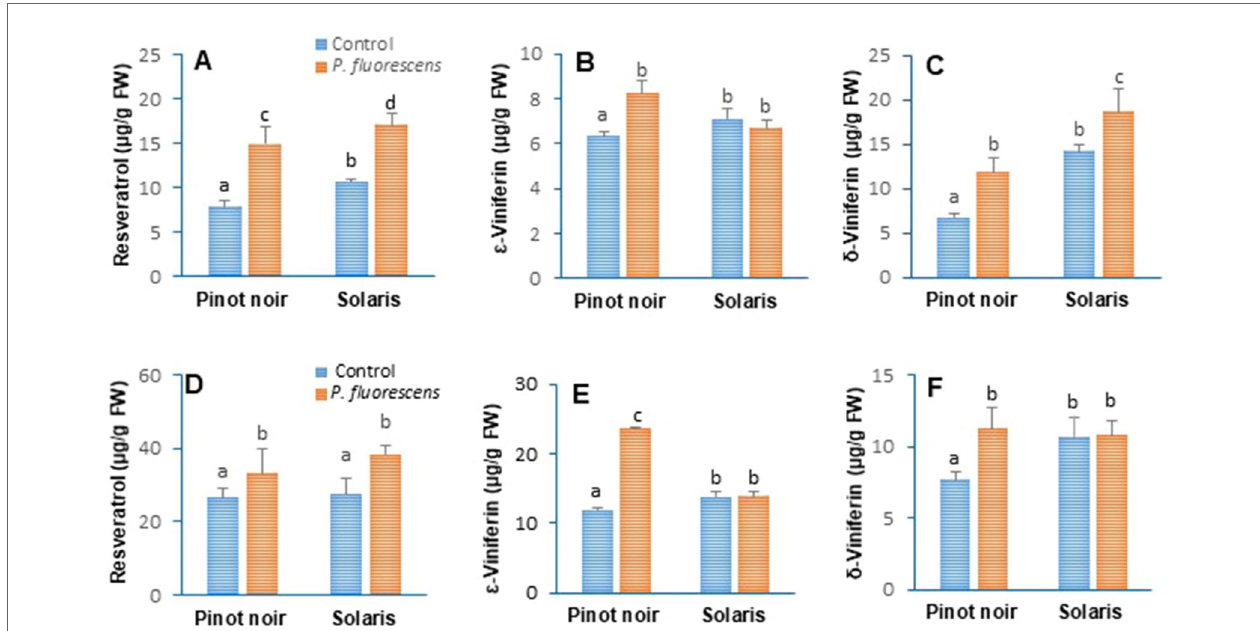
FIGURE 7 | Pseudomonas fluorescens PTA-CT2 primes phytoalexin accumulation in leaf disks of Pinot noir and Solaris after Plasmopara viticola and Botrytis cinerea inoculation. Grafted plants were treated with P. fluorescens PTA-CT2 at the root level. Two weeks later, leaf disks were excised from control and treated plants and infected with 20 µl of 10 5 spores per milliliter of P. viticola (A–C) or 5 µl of 10 6 conidia per milliliter of B. cinerea (D–F) . The amounts of resveratrol (A, D) , ε -viniferin (B, E) , and δ -viniferin (C, F) were determined by ultra-performance liquid chromatography (UPLC) at 2 days post inoculation. Values corresponding to uninfected control or PTA-CT2-treated plants are similar to those before inoculation ( Figure 1 ), with less than 1 μg g −1 FW. Data are the means from three independent experiments performed in 2016, and vertical bars indicate standard deviation. Different letters indicate statistically significant differences between the treatments (ANOVA Tukey test, P < 0.05).